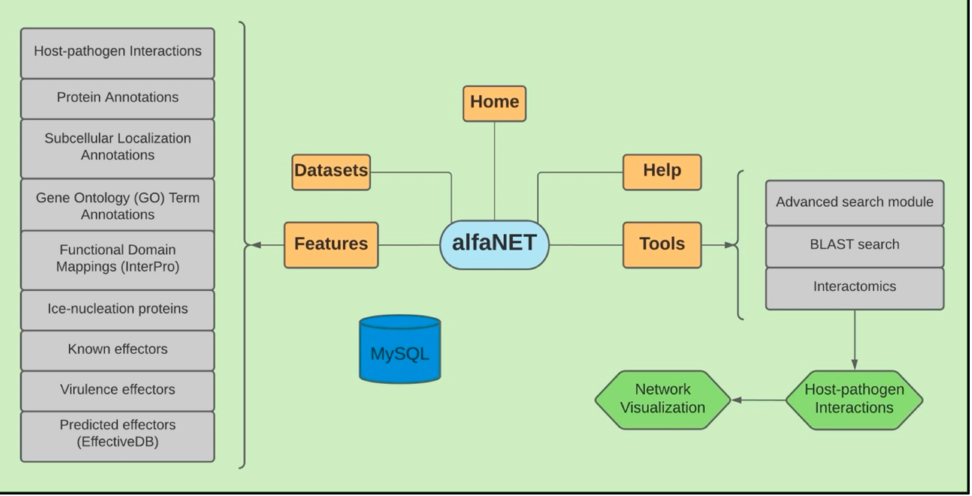
Figure 1. Sitemap architecture of the alfaNET